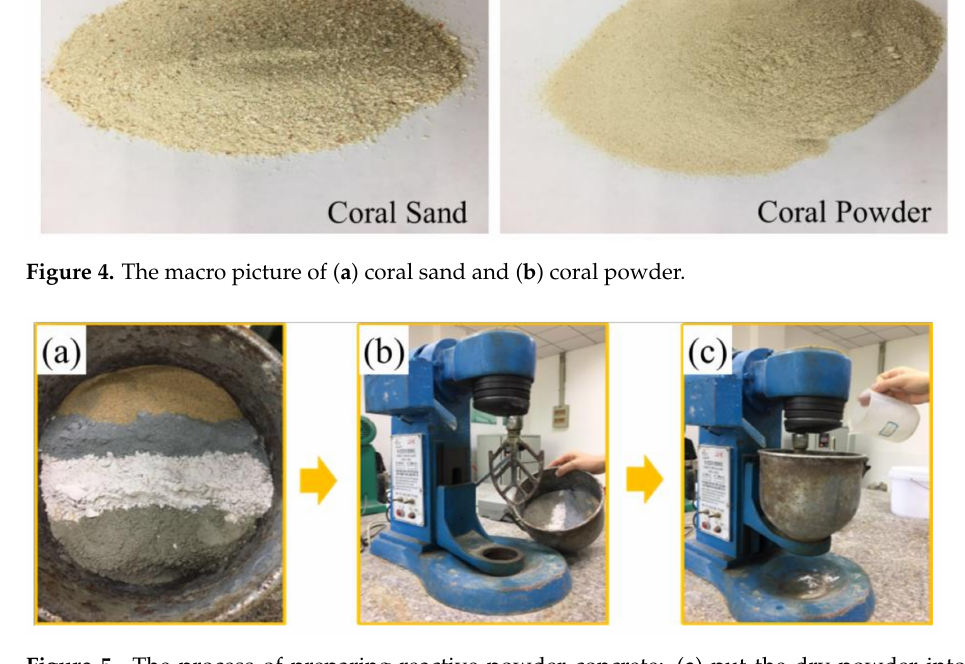
Figure 5. The process of preparing reactive powder concrete: ( a ) put the dry powder into the container; ( b ) stir the dry powder; ( c ) add water for further